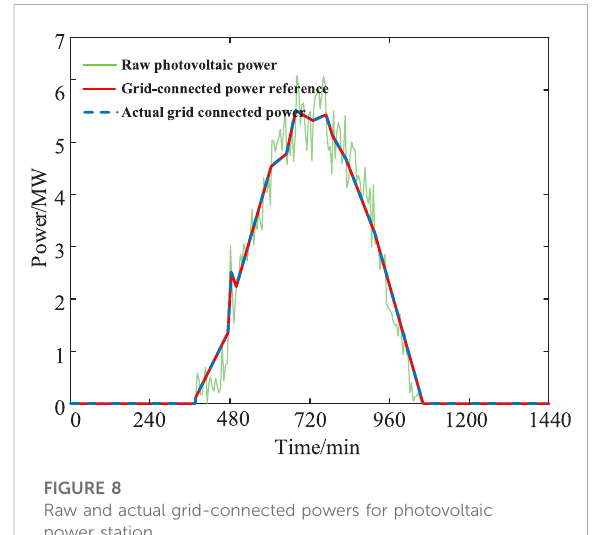
FIGURE 8 Raw and actual grid-connected powers for photovoltaic power